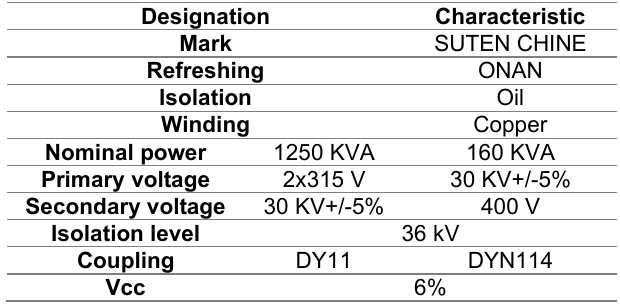
Table 10. Power transformer technical specifications